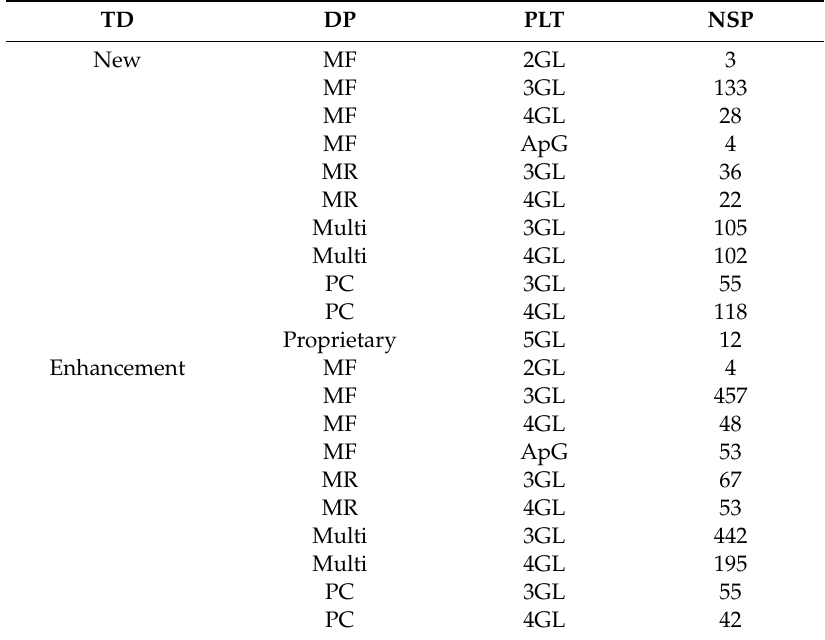
Table 4. Projects classified by type of development (TD), development platform (DP), and programming language type (PLT), NSP: Number of software projects.